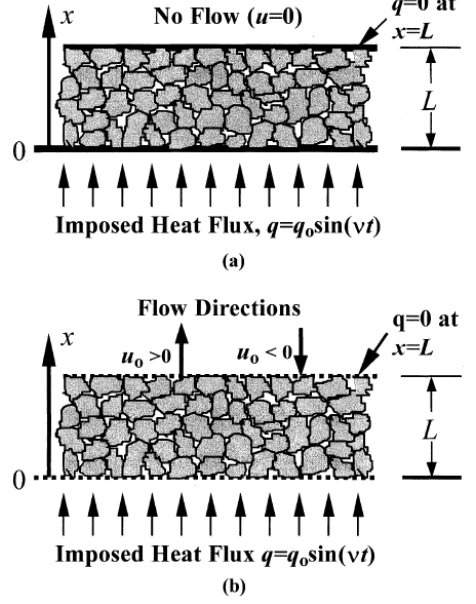
Figure 1. Porous layer under constant heat flux; ( a ) without fluid flow, ( b ) with fluid flow, where, q o is the heat flux amplitude and ν is the frequency, considered by Minkowycz et al. [32]. Kim and Jang [33] proposed a new criterion for the LTE condition, which is